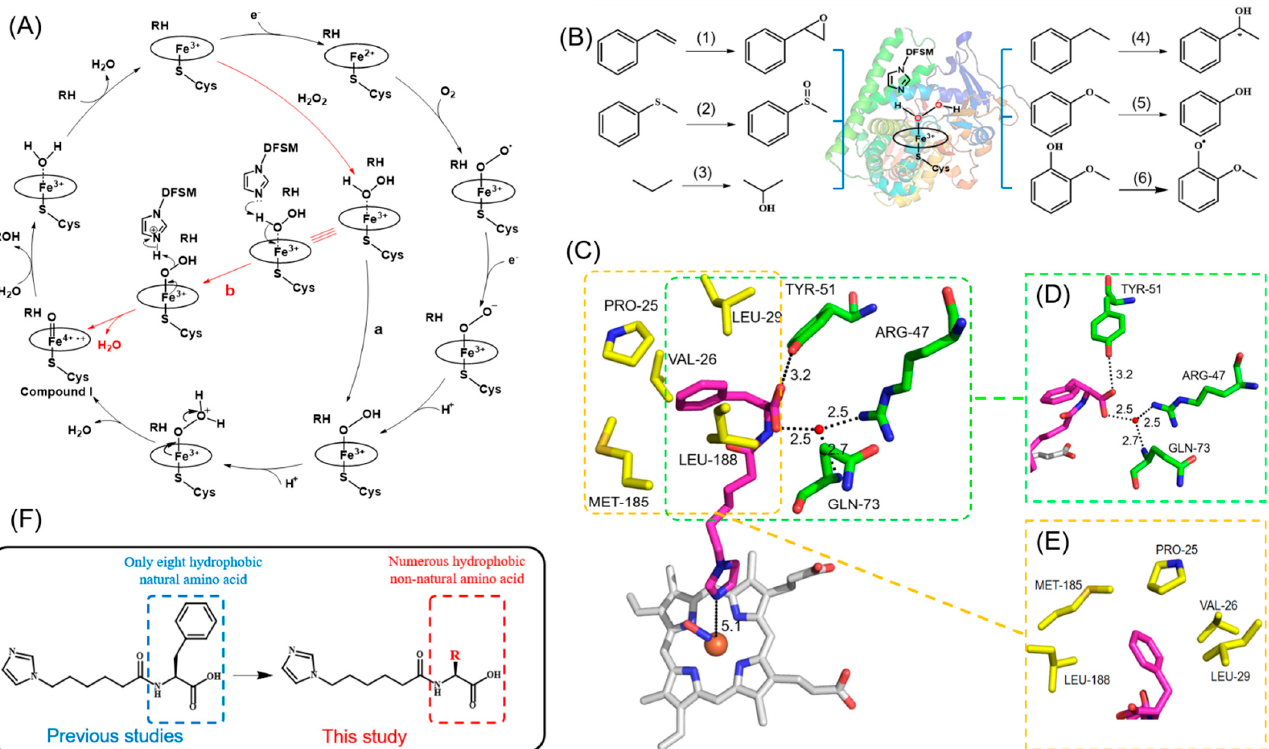
Figure 1. ( A ) The catalytic cycle of P450 monooxygenase and the proposed mechanism of DFSM- activated peroxide-shunt pathway to generate the artificial P450BM3 peroxygenase. a: The peroxide-shunt pathway without the addition of the DFSMs; b: DFSM-activated peroxide-shunt pathway. ( B ) Typical reactions catalyzed by the DFSM-facilitated P450BM3-H 2 O 2 system: 1. styrene epoxidation; 2. thioanisole sulfoxidation; 3 and 4. hydroxylation of alkanes and aromatic compounds, 5. demethylation of aromatic ethers; 6. one-electron oxidation of phenol. ( C ) Co-crystal structure of P450BM3 and the DFSM Im-C6-Phe (PDB No. 7EGN [42]). ( D ) Hydrogen bond networks between Im-C6-Phe and P450BM3. ( E ) Hydrophobic interactions between the anchor group of Im-C6-Phe and P450BM3. ( F ) Co-crystal structure-guided optimization of the DFSM by introducing hydrophobic unnatural amino acids.